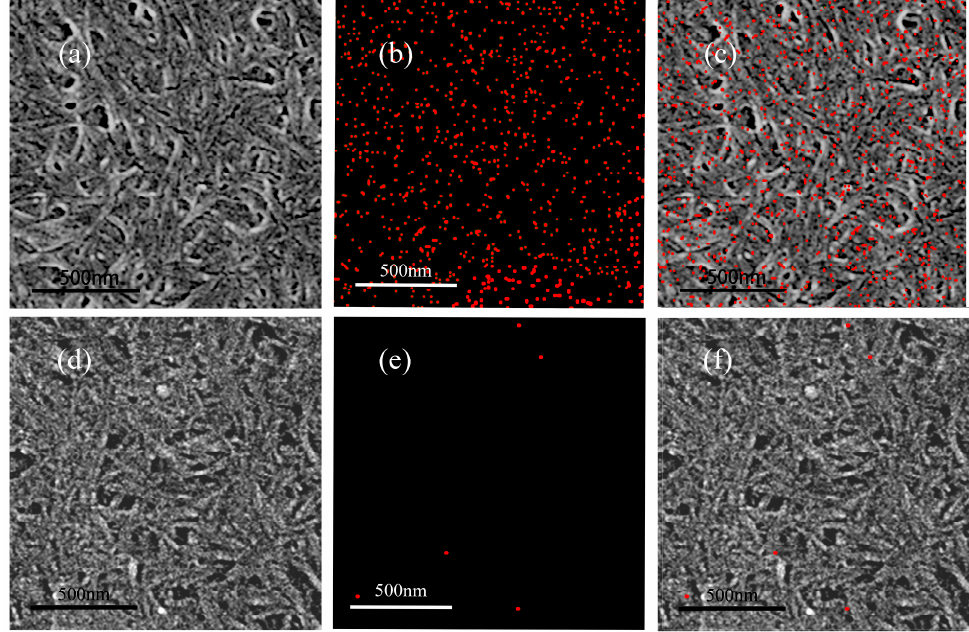
Figure 3. Mapping analysis of CNC before and after the adsorption of chloropropanol.